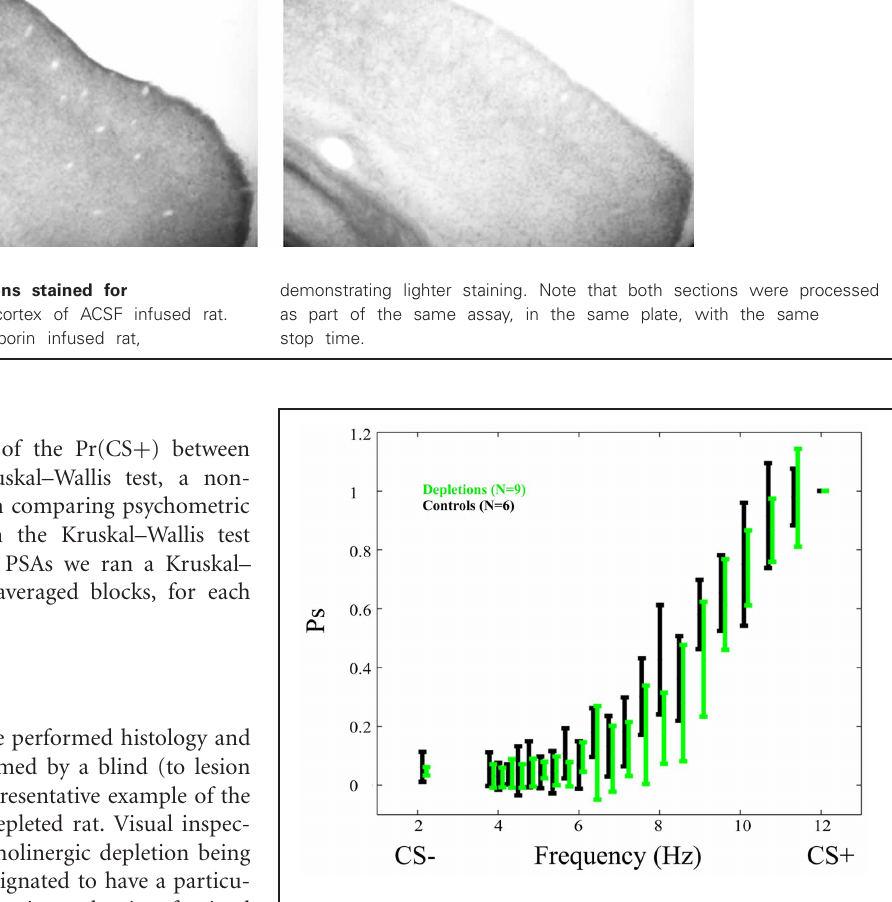
FIGURE 3 | Psychometric curves in the test phase of the performance experiment . Data for depletion (192 IgG-Saporin) and control (ACSF) groups are depicted in green and black, respectively. In this experiment depletions were performed after learning had taken place. The fact that the psychometric curves do not differ significantly is an indication that cortical acetylcholine has no direct effect on the ability of rats to discriminate temporally modulated visual stimuli (lights flashing at different frequencies). Ps is the probability of responding to a given frequency normalized to the response to the CS + . The Frequency (Hz) represents the frequency at which the stimulus is flashing. Error bars represent the standard